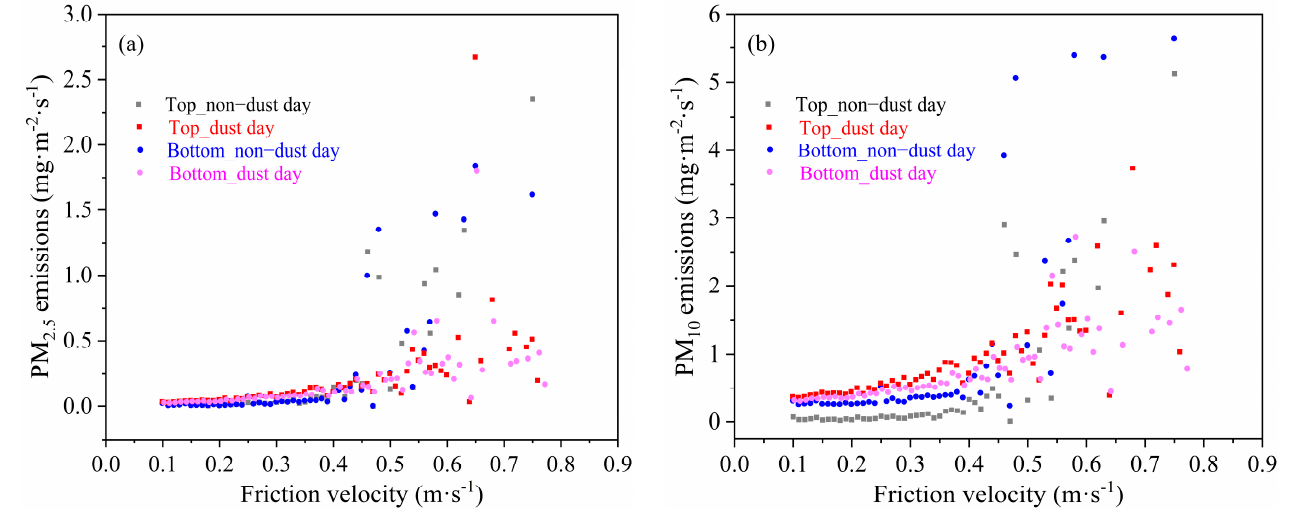
Figure 10. Friction velocity vs. dust emissions generated in the saltation process at the top and bottom of dunes in the TD. ( a ) PM 2.5 and ( b ) PM 10 .